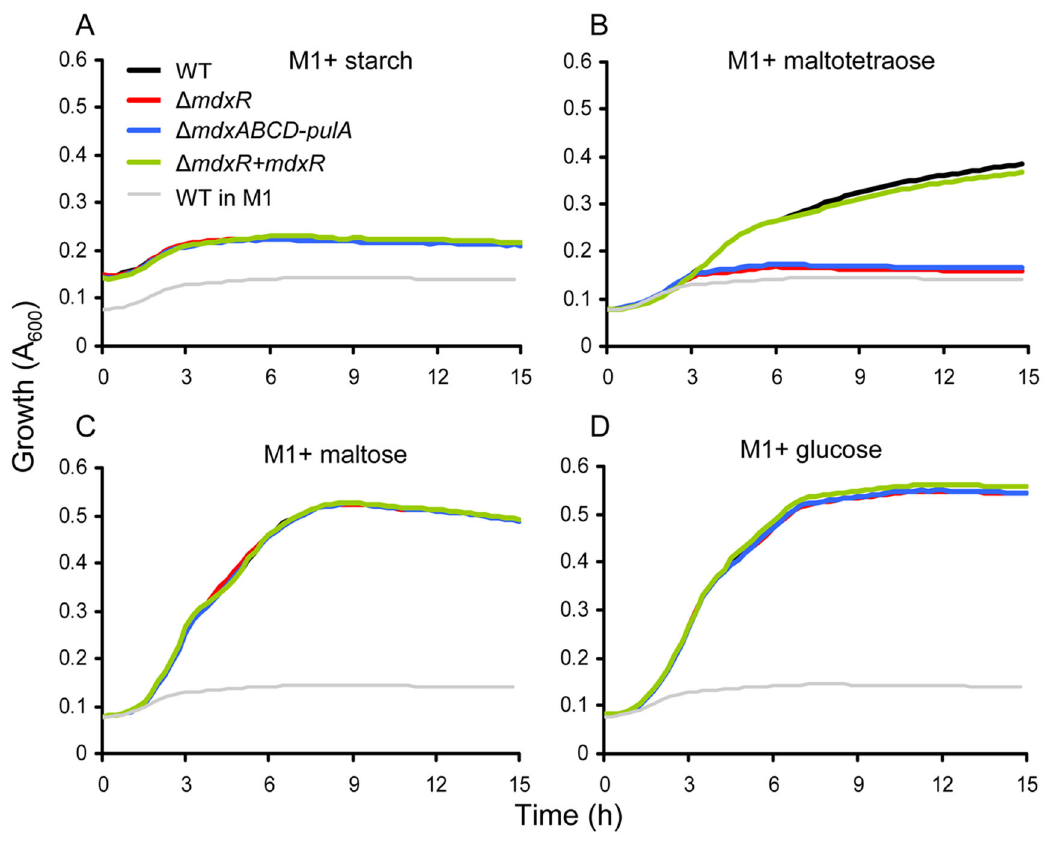
Figure 2. Growth of E. faecium on starch, maltotetraose, maltose and glucose. Growth curves of E. faecium E1162 wild-type (black), its isogenic mutants Δ mdxR (red) and Δ mdxABCD-pulA (blue), and the in trans complemented strain Δ mdxR+mdxR (green) on starch (panel A), maltotetraose (panel B), maltose (panel C) and glucose (panel D) are shown. The growth curve of E1162 wild- type in M1 was shown in grey as a negative control. Overnight cultures were inoculated at an initial OD semi-defined minimal medium M1 [9], M1 supplemented with 2.5 g/l of starch, maltotetraoise, maltose or glucose as sole carbon source, respectively, and then incubated in the Bioscreen C system at 37° C with continuous shaking. The absorbance of 600nm (A ) was recorded every 15 min for 12 hours. Growth curves are mean data of three independent experiments. Note that A 600 the start of the experiment is higher in M1 + starch than in the other conditions, due to increased turbidity of the medium containing